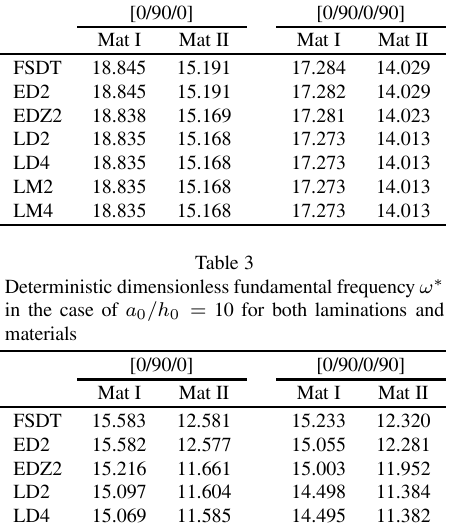
Table 2 Deterministic dimensionless fundamental frequency ω ∗